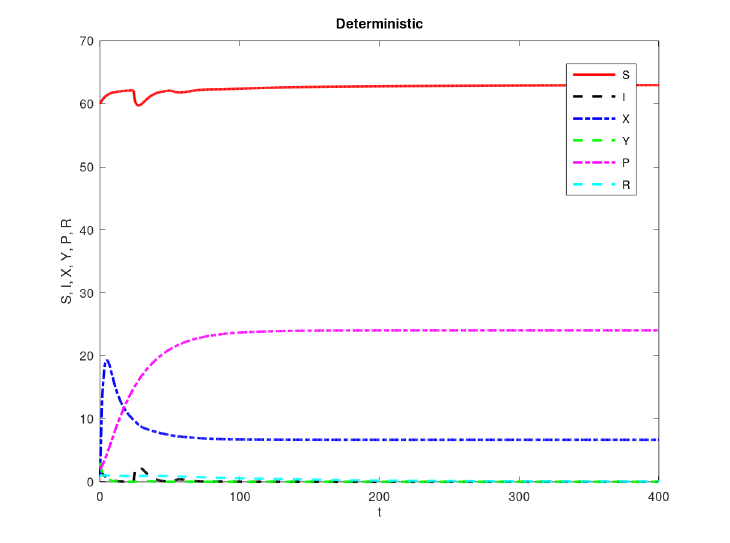
Figure 8. Plots for the virus plant model with saturations and delays for the deterministic model.